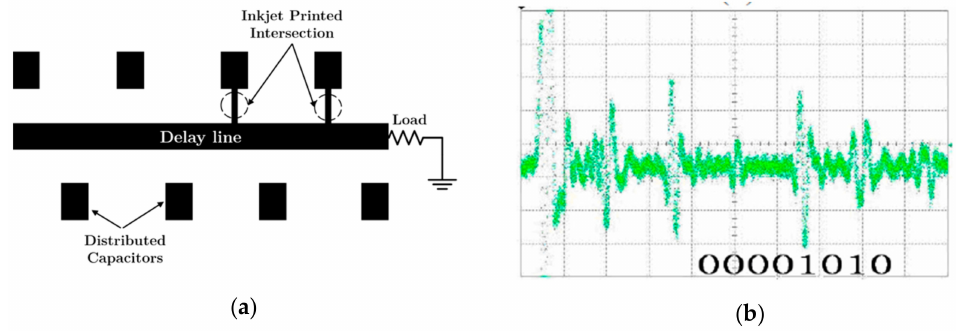
Figure 4. ( a ) Layout of the chipless-RFID tag proposed by Zheng et al. programmed with the code ‘00001010’ and ( b ) measurement of the code ‘00001010’. Figure extracted from